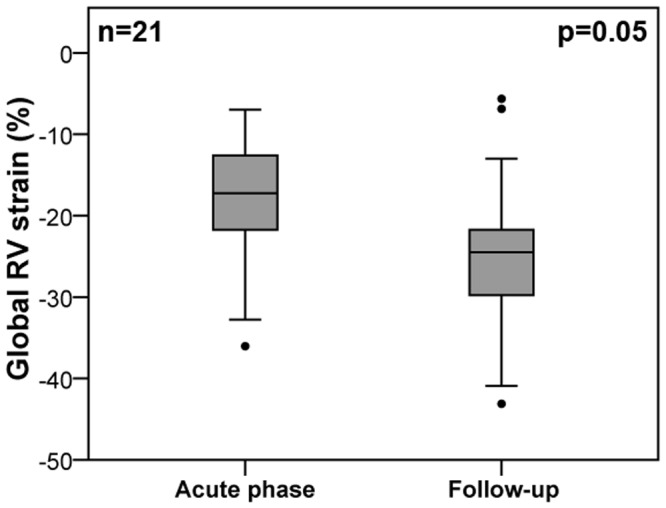
Recovery of global right ventricular strain in Takotsubo syndrome.Box (25th percentile, median, 75th percentile) and whisker (10th and 90th percentile) plots illustrating recovery of global RV strain during follow-up. RV = right ventricular.